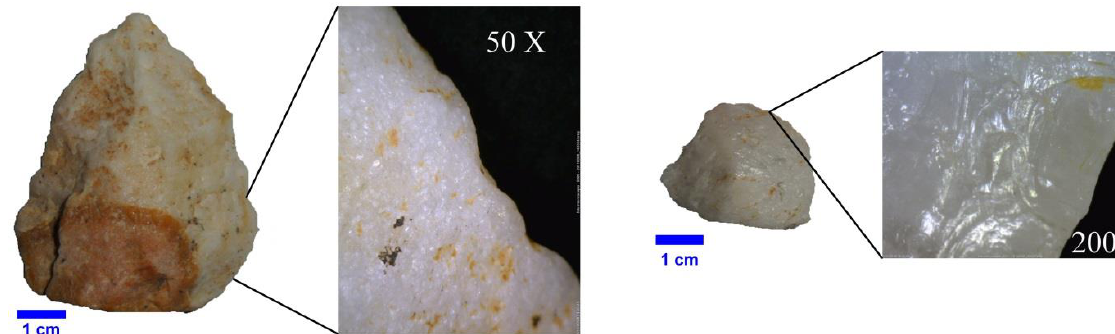
Figure 11. Mousterian point from the Ciota Ciara cave showing use-wear traces due to the processing of medium-hard materials (on the left); non-retouched flake showing use-wear traces due to the processing of medium-soft materials. The scale bars to the lower left of each macroscopic image are 1 cm